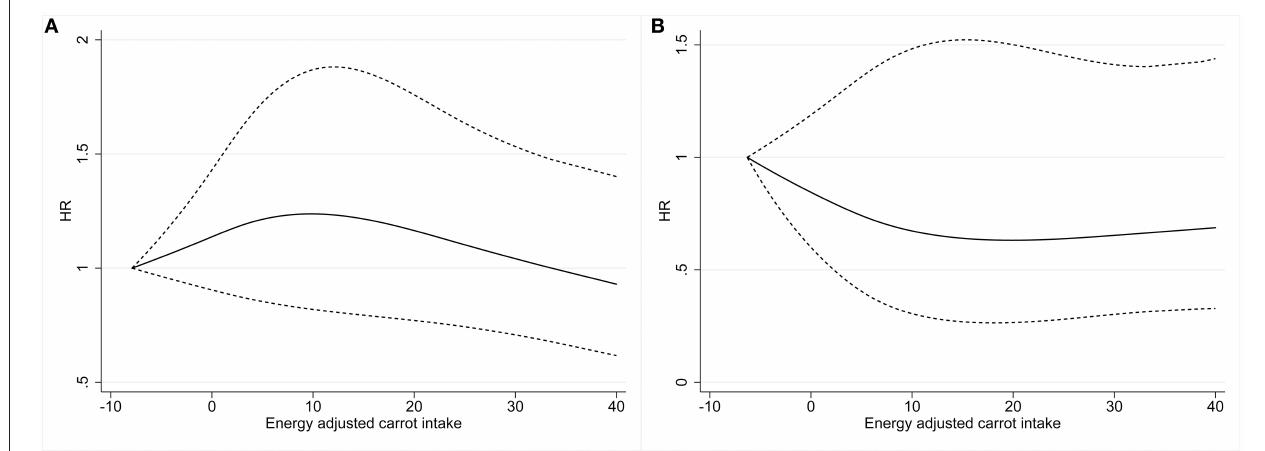
FIGURE 1 | Dose-response analysis was performed using restricted cubic spline model for the association between energy-adjusted dietary carrot intake and bladder cancer risk in males (A) and females (B) . Solid lines represent point estimates and dashed lines represent 95% CIs. HRs were calculated by restricted cubic spline regression with three knots (i.e., 10th, 50th, and 90th percentiles) adjusting for age, sex, race, BMI, education, smoking status, drinking status, marital status, family history of cancer, arm, Supplemental Beta-Carotene, Supplemental Calcium, Supplemental Vitamin A, Supplemental Vitamin C, Supplemental Vitamin D, and Supplemental Vitamin E. HR, hazard ratio; CI, confidence interval; BMI, body mass